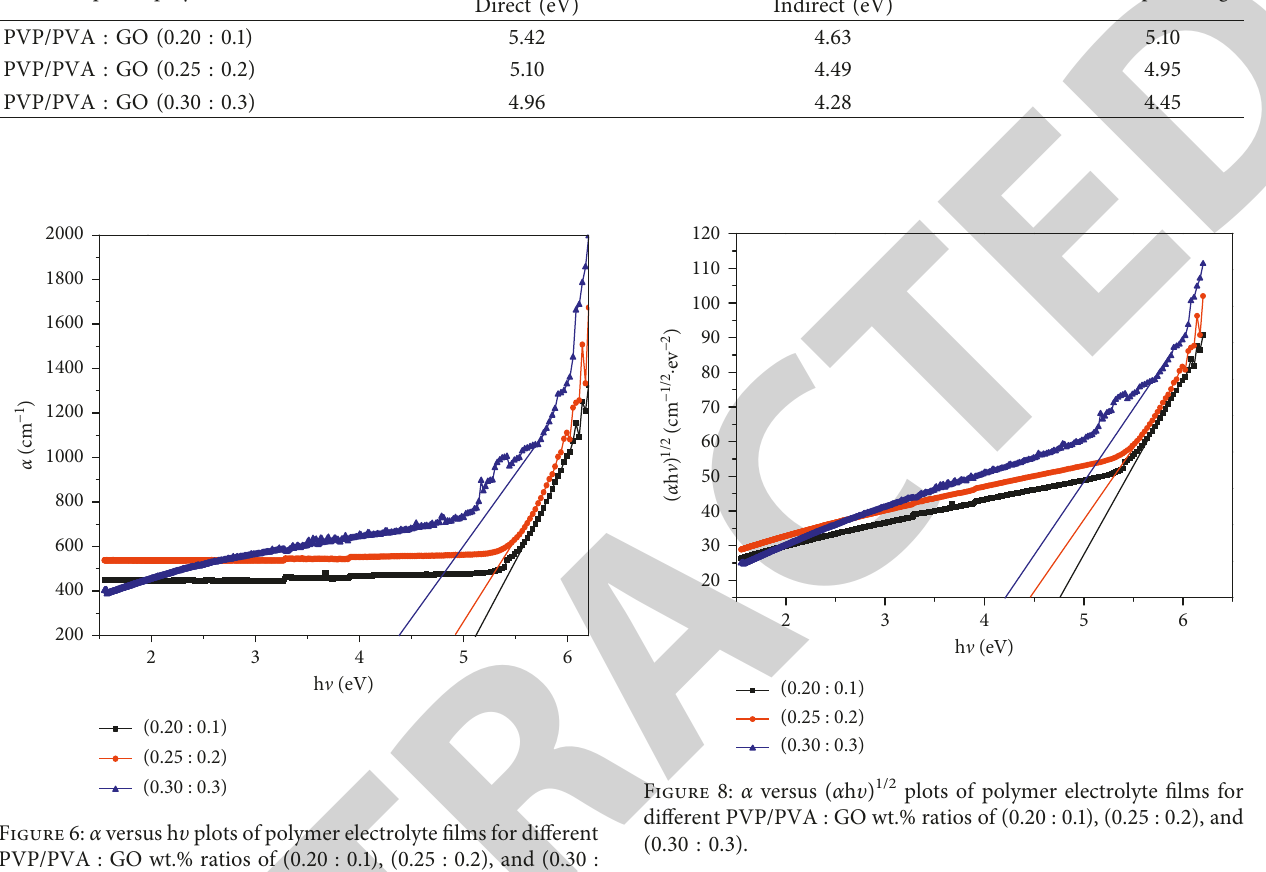
Table 2: Optical bandgap values of PVP/PVA : GO nanocomposite polymer films. Optical bandgap Nanocomposite polymer films Direct (eV)